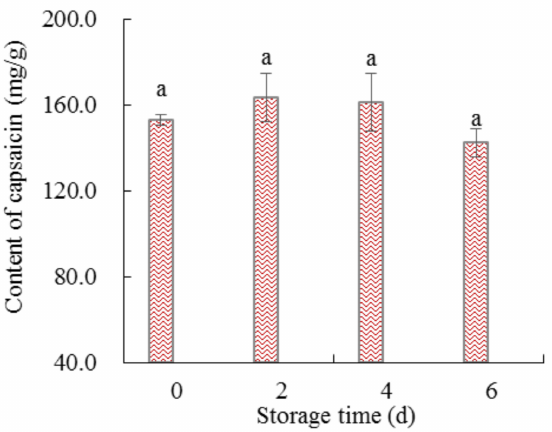
Figure 6. The content of capsaicin in the marinated pork. Values are presented as mean ± standard deviation. Different letters above the bars highlighting the standard deviations indicate significant differences ( p < 0.05).